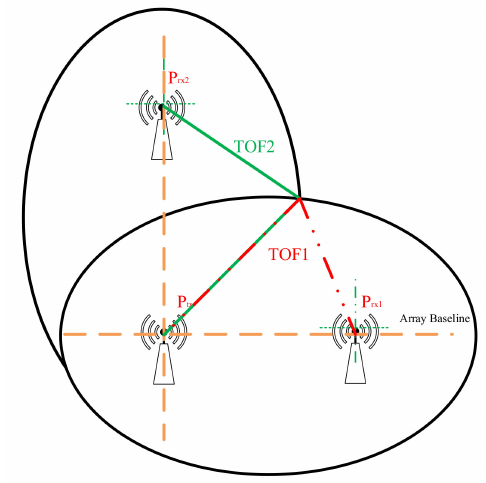
Figure 6. Schematic diagram of starting position